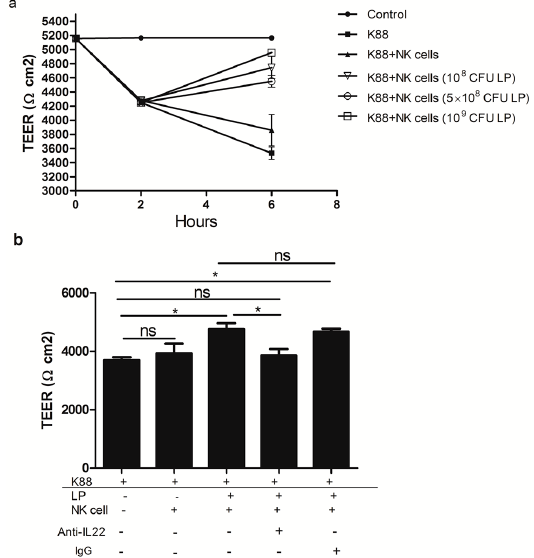
Figure 4. Changes in NCM460 cell monolayers Trans-Epithelial Electrical Resistance (TEER) after different treatments. ( a ) NCM460 cell monolayers were infected or not with 10 8 CFU/mL of enterotoxigenic Escherichia coli (ETEC) K88 for 2 h, and then NK cells stimulated or not by Lactobacillus plantarum (LP) (10 8 , 5 × 10 8 , 10 9 CFU/mL) were added to the NCM460 cell monolayers challenged with ETEC K88 and co-cultured for another 4 h. TEER values were determined at 0, 2, and 6 h post treatment; ( b ) NK cells stimulated by 10 9 CFU/mL LP in the presence or absence of either 5.0 µg/mL polyclonal anti-IL-22 antibody against IL-22 or 5.0 µg/mL control goat IgG were added to the NCM460 cell monolayers challenged with ETEC K88. After the treatment, TEER was detected. Data are means ± SEM. * p < 0.05, ns: not significant. TEER, trans-epithelial electrical resistance.